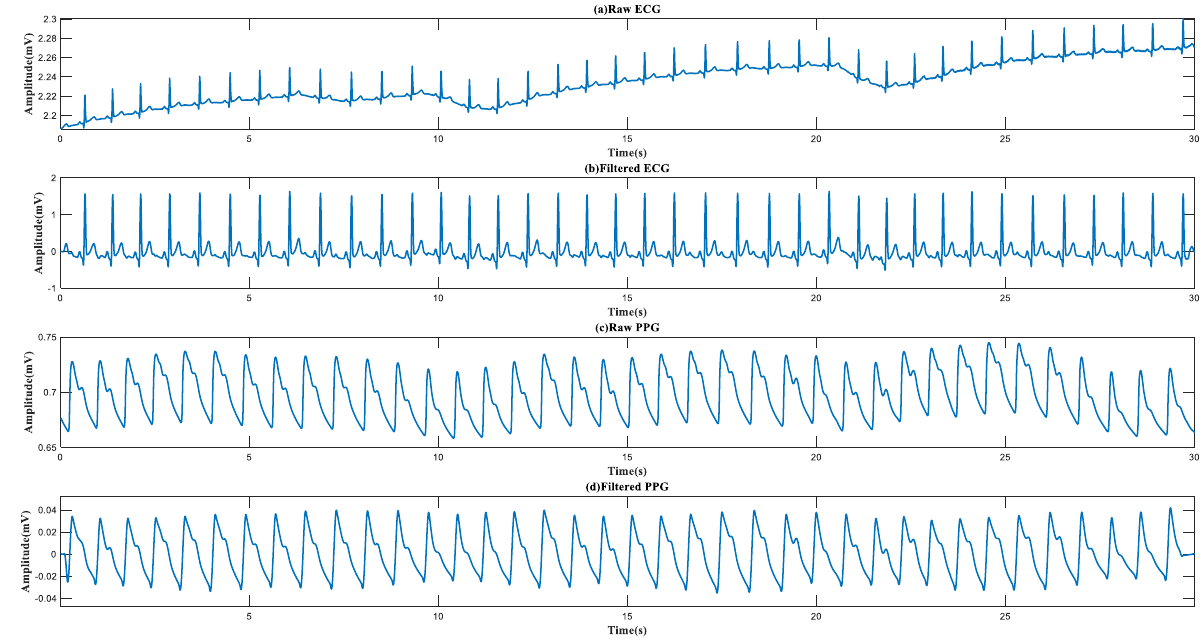
Figure 5. Raw and filtered PPG and ECG signals acquired from eMMC within 30